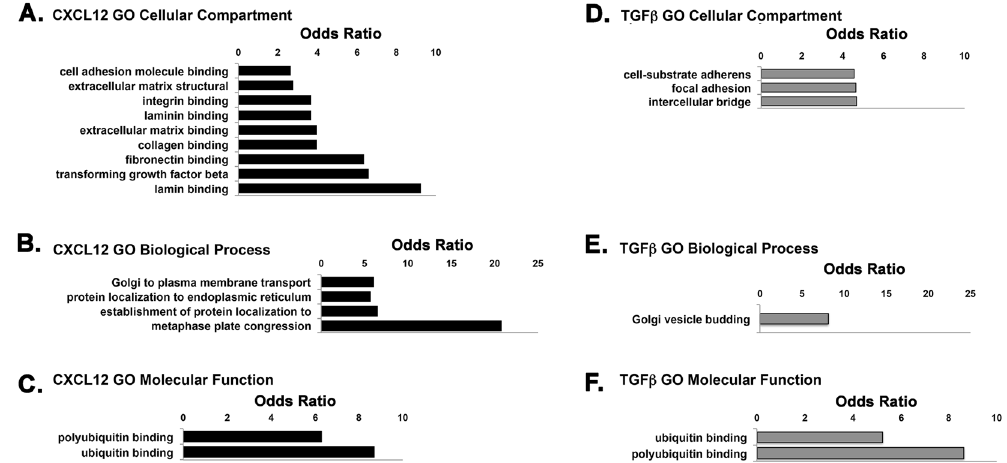
Figure 2. Gene Ontology Analysis of CXCL12- and TGF β -Induced Transcriptomes. Log odds ratios indicate the relative abundance of Gene Ontology (GO) terms compared to random distribution as categorized by cellular compartment ( A , D ), biological process ( B , E ) or molecular function ( C , F ). Terms related to extracellular matrix and matrix components in the GO cellular compartment category were significantly higher (a significantly higher number of genes related to these terms in this category were up-regulated) for CXCL12- treated ( A ) than TGF β -treated ( D ) cells, as were biological process terms for Golgi and ER localization and transport ( B , E ) and molecular function terms for ubiquitin and polyubiquitin binding ( C , F ). The complete log odds ratio analysis of Gene Ontology terms is provided in Supplementary File.